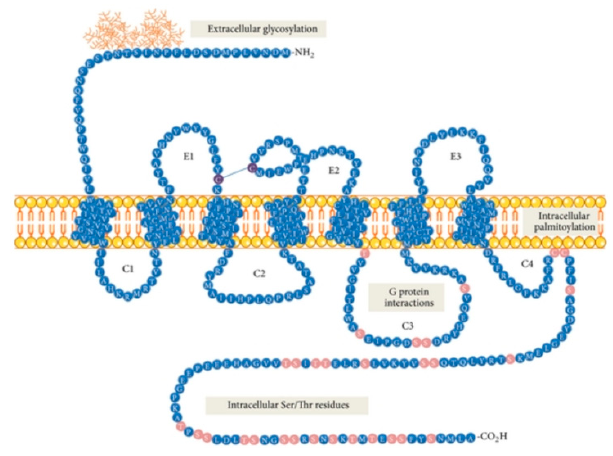
Figure 1. Schematic model of NK1 receptor of full length isoform (NK1R-Fl) [3].